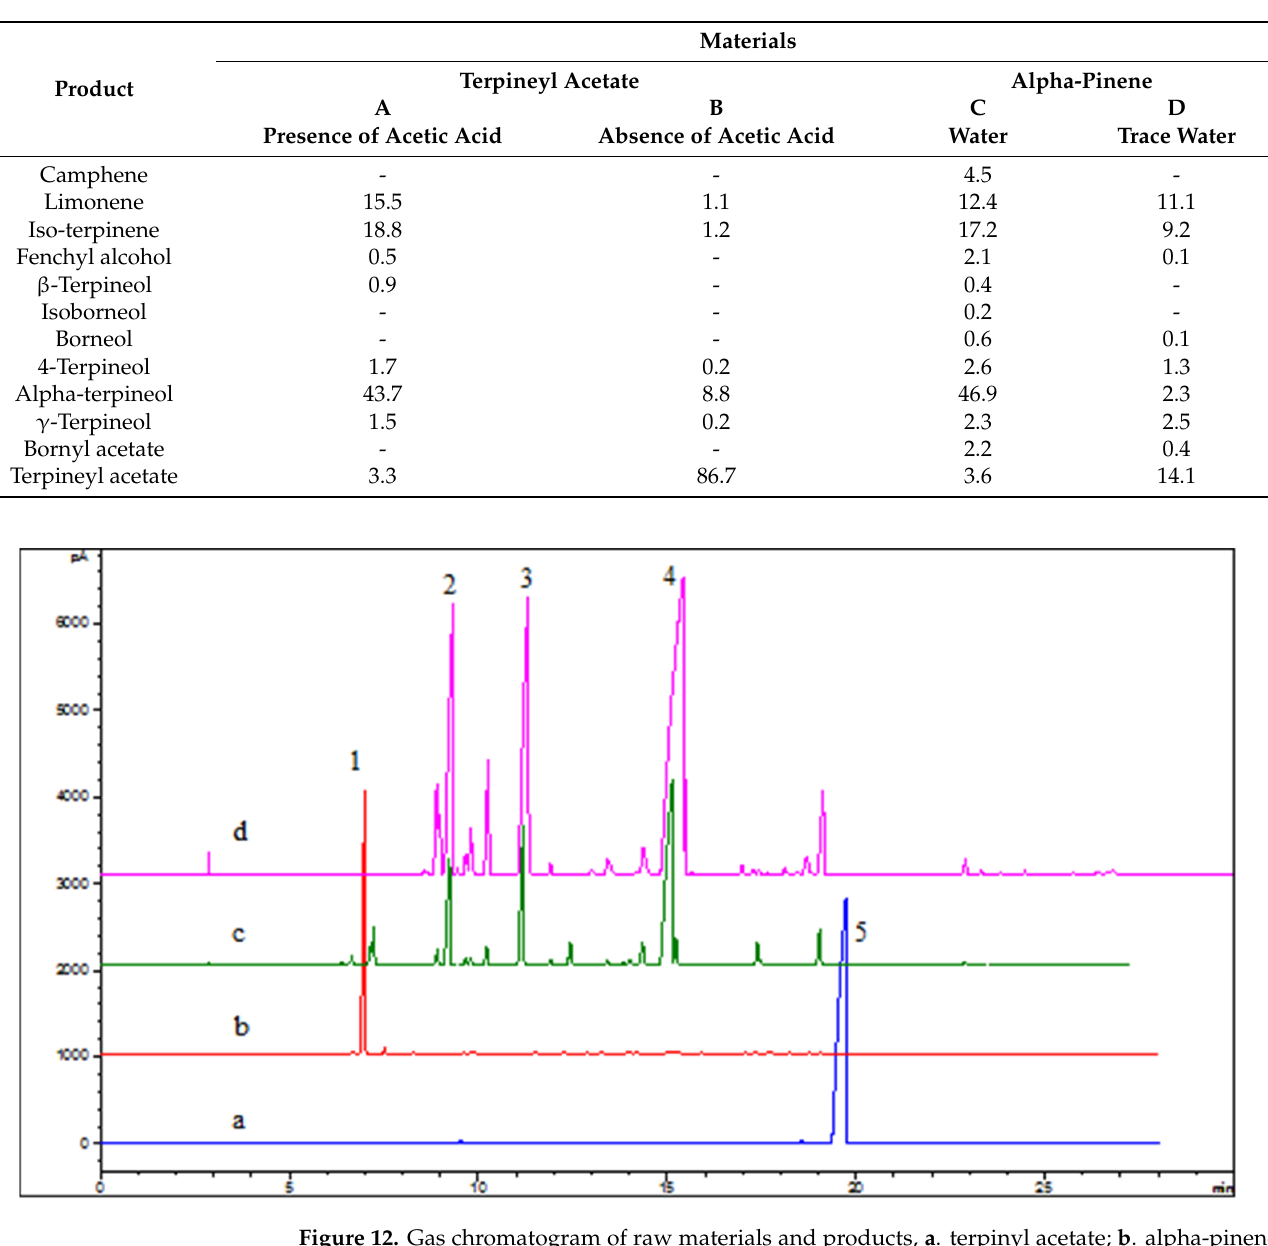
Table 6. Reaction results for the different initiators.